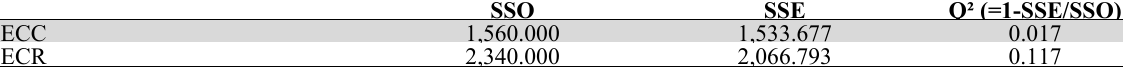
Predictive Capability of the Model (Construct Cross-Validated Redundancy)